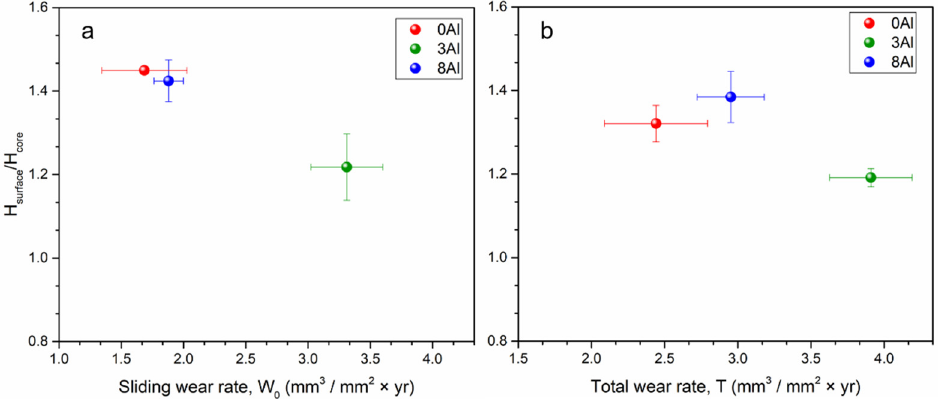
Figure 15. H surface /H core value for each material as a function of ( a ) pure sliding wear and ( b ) total wear rates. wear